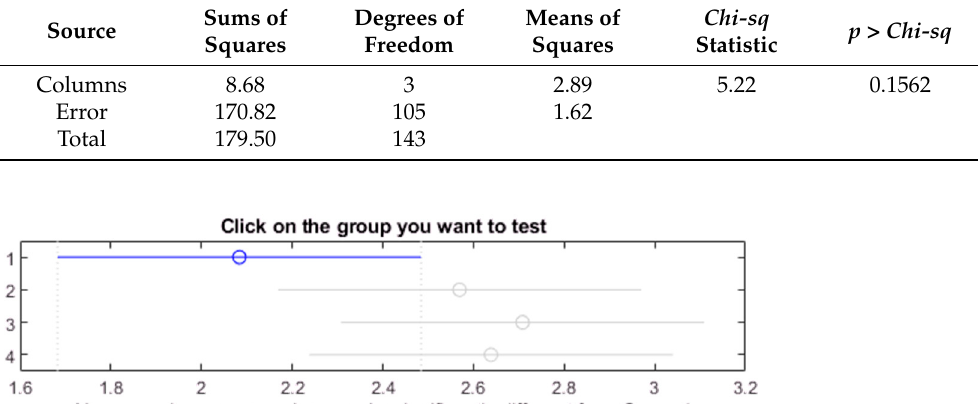
Table 14. Results of Friedman test for oil Midel 1204 with different concentrations of surfactant oleic acid.